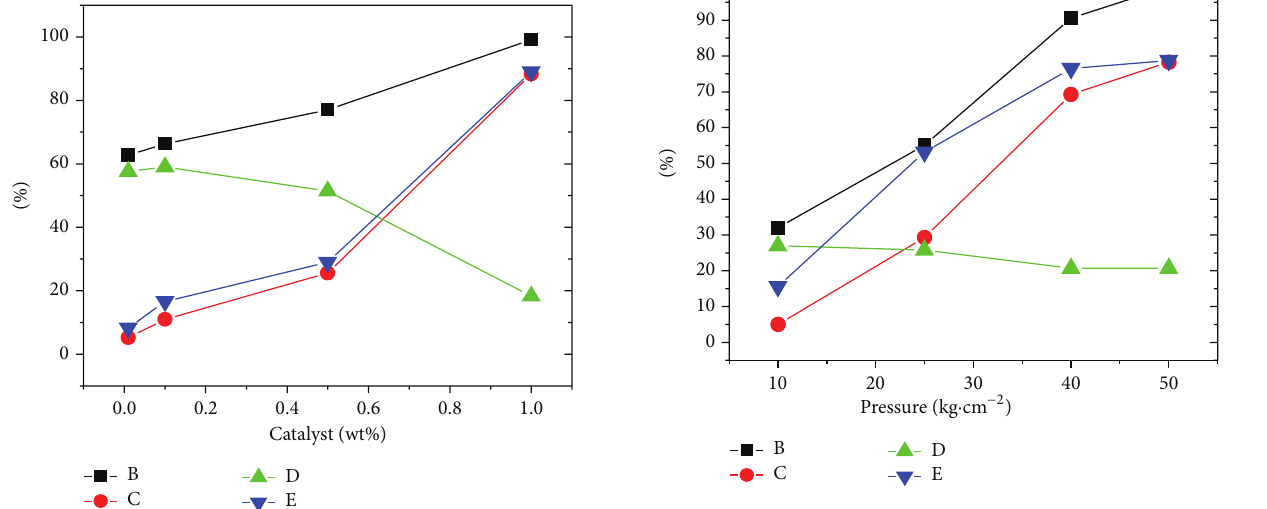
Figure 8: Effect of pressure on catalyst performance. Temp. = 378 K, catalyst loading = 1%, duration = 4 hrs. B = conversion, C = PEA yield, D = Others, and E =